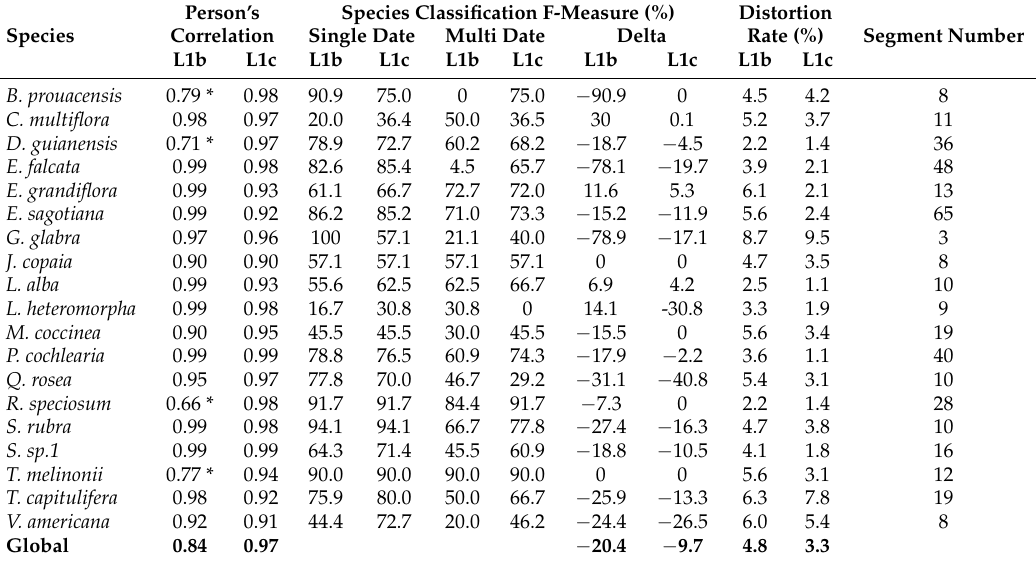
Table 8. Person’s correlation between spectral correlation matrices at each date for two processing pathways, corresponding classification F-measure * and spectrum distortion rates (multiple date scenario, see text). L1b and L1c refer to L1b Spa.F, norm., Sha.R and to L1c Spa.F, norm., Sha.R data